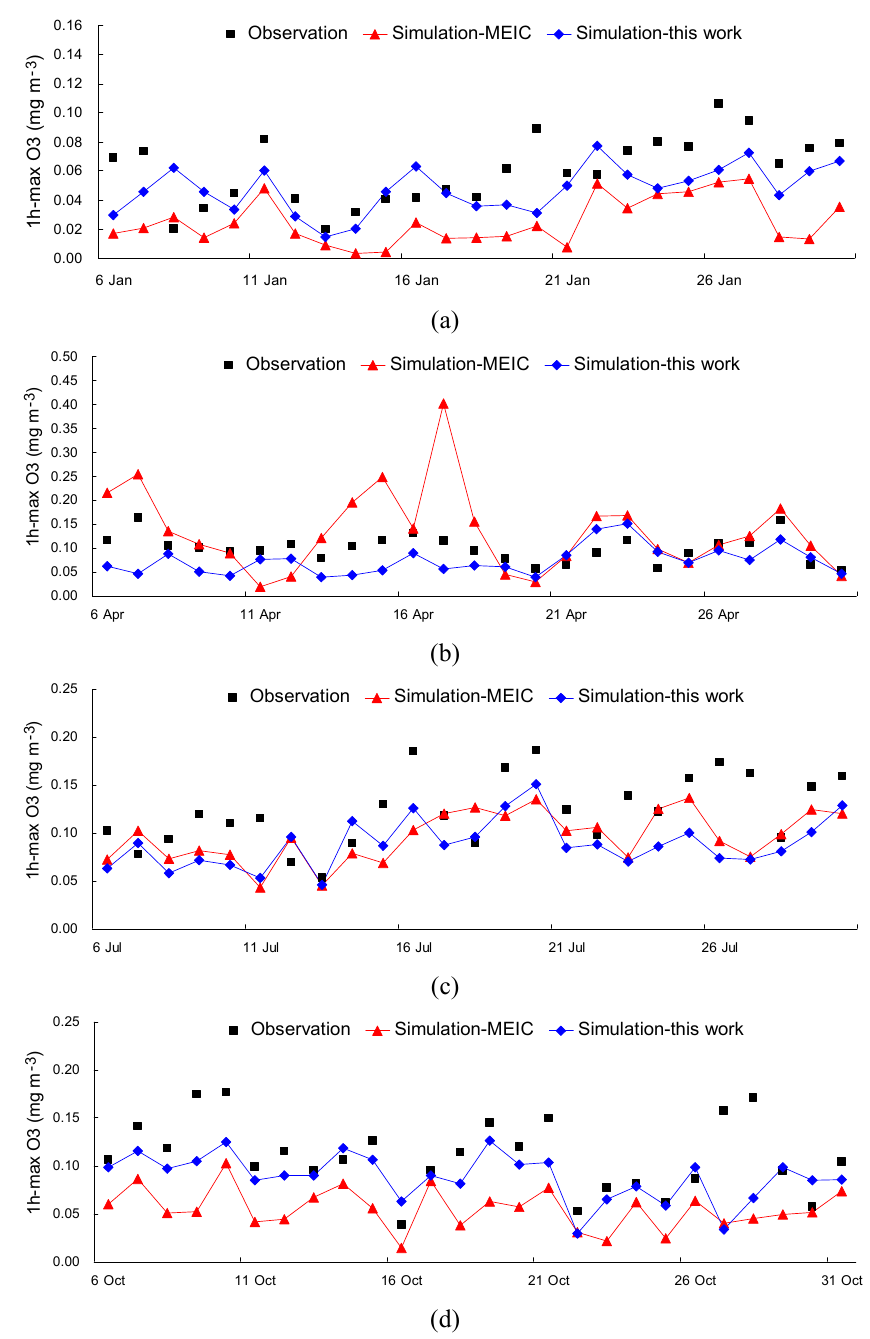
Figure 10. Observed and simulated daily 1h maximum O 3 concentrations using MEIC and the provincial emission inventory in January (a) , April (b) , July (c) and October (d) in 2012 at the air quality monitoring sites in Nanjing. Note the different y -axis scales between